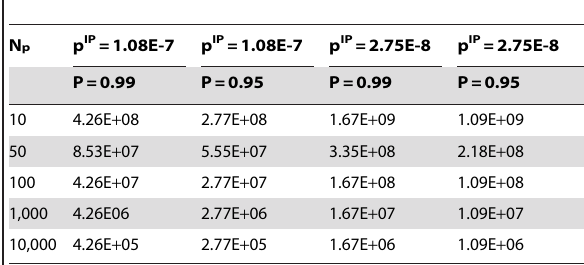
Table 4. Sequence read depth required for hypothetical sequencing based Dengue virus-like screening